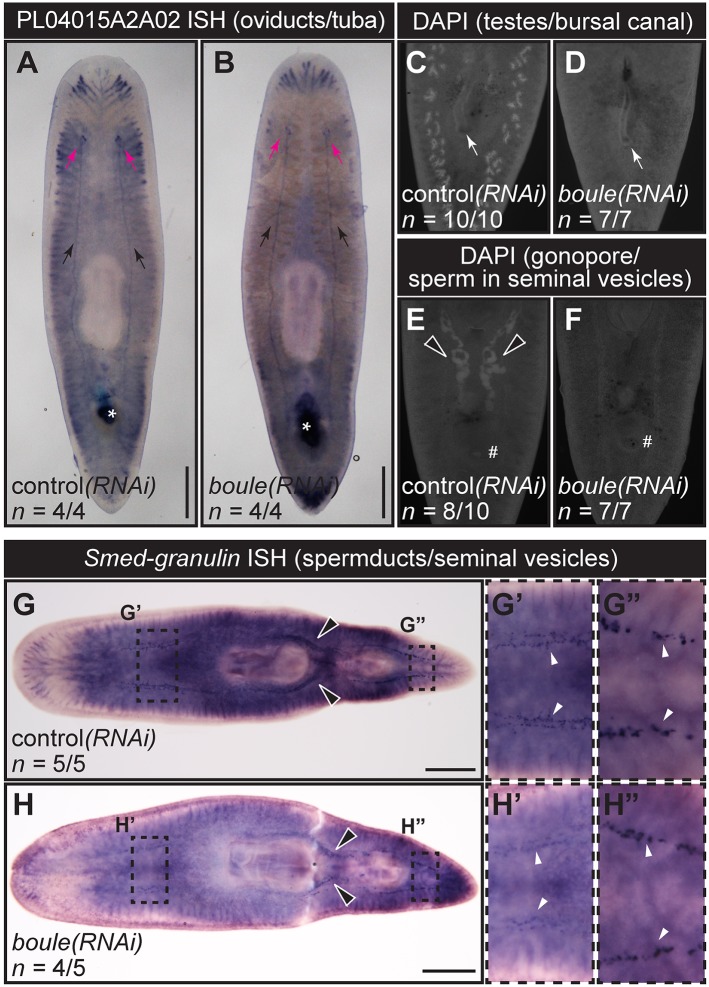
Smed-boule RNAi does not affect development of somatic reproductive structures.Whole-mount in situ hybridization (ISH) analysis of planarians subjected to three months of control (A, C, E, and G) or Smed-boule
(B, D, F, H) RNAi revealed no differences between these two samples in development of oviducts (black arrows in A-B), atrium (asterisks in A-B), tuba (pink arrows in A-B), spermducts (white arrow heads in G’-G” and H’-H”), or seminal vesicle development (black arrowheads in G-H). DAPI staining of these samples revealed that development of the bursal canal (white arrow in C-D) and gonopore (pound sign in E-F) were indistinguishable. However, DAPI staining only revealed sperm in testes and seminal vesicles (black arrowheads) of control animals (E-F). The fraction of animals displaying the phenotype represented by the image is shown at the bottom-left corner of each frame. Scale bars = 1 mm.